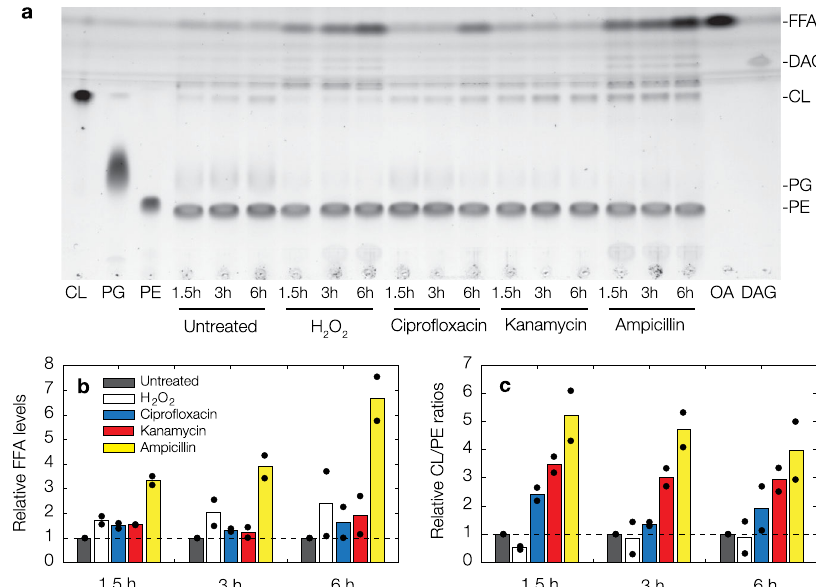
Fig. 5 Antibiotic treatment is associated with changes in lipid composition. a Representative thin-layer chromatography image for lysates of control and antibiotic-treated cell cultures. Cells were harvested after various treatment times as shown, and antibiotic concentrations used were 10× MIC. For comparison, results for cells treated with 10 mM hydrogen peroxide and 10× MIC ampicillin are shown. Results are representative of two biological replicates. Abbreviations: CL, cardiolipin; PG, phosphatidylglycerol; PE, phosphatidylethanolamine; FFA, free fatty acids; DAG, diacylglycerol; OA, oleic acid. b , c Relative FFA levels ( b ) and CL/PE ratios ( c ) across treatment conditions, relative to values for untreated cells at each treatment time. Data are from two biological replicates (black points), and bars indicate